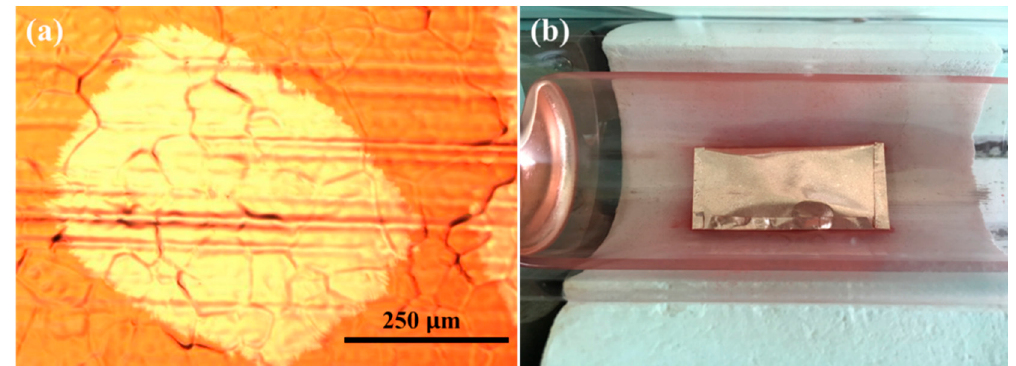
Figure 3. ( a ) An optical micrograph of single-crystal graphene with a diameter of 450 μ m under-200 times magnification observation. ( b ) The physical object of the copper pocket.